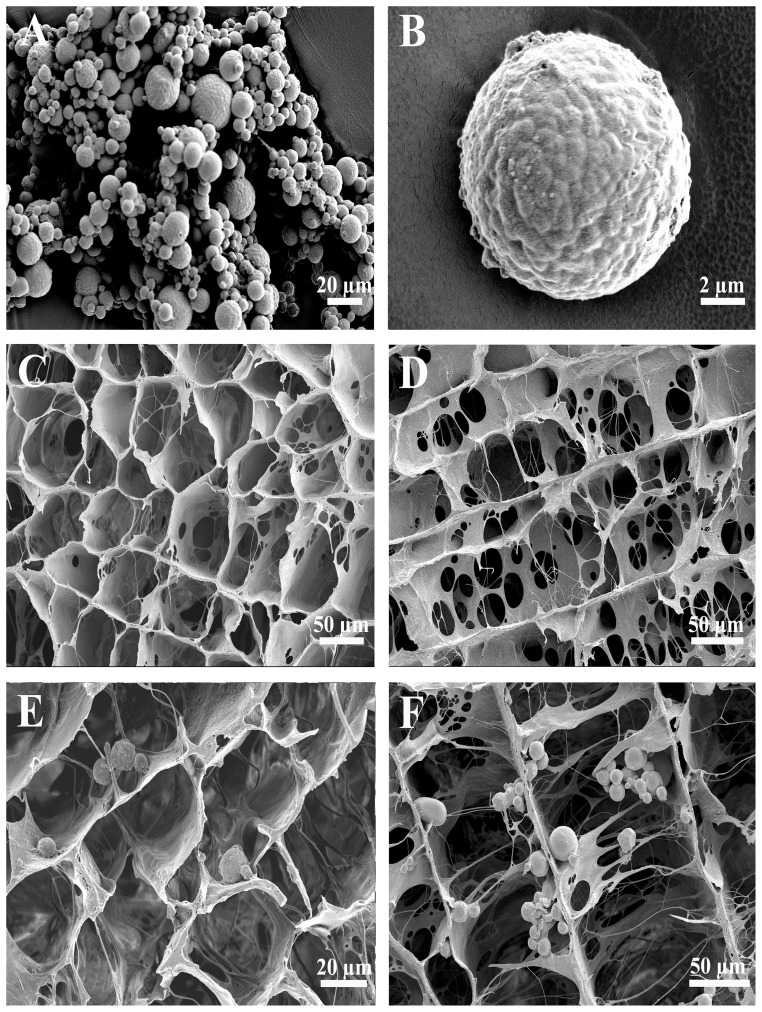
Microstructure appearance of the NGF–CMSs, CCH, and NGF–CMSs/CCH.Scanning electron microscopy images of the NGF–CMSs (A and B) show relative rough surface and spherical shape without hollows or deformations. Scanning electron microscopy images of the CCH scaffold in a transverse section (C) show that the microchannels were arranged in a honeycomb-like pattern. The longitudinal section of the CCH (D) shows the longitudinally oriented microchannels. Scanning electron microscopy images of the NGF–CMSs/CCH in a transverse section (E) show slightly different morphologies with pores, which were less regular and smaller than that of the CCH scaffold. The longitudinal section of the NGF–CMSs/CCH shows that the NGF–CMSs were evenly distributed throughout the longitudinally oriented microchannels which did not influence the microstructures of the scaffolds.